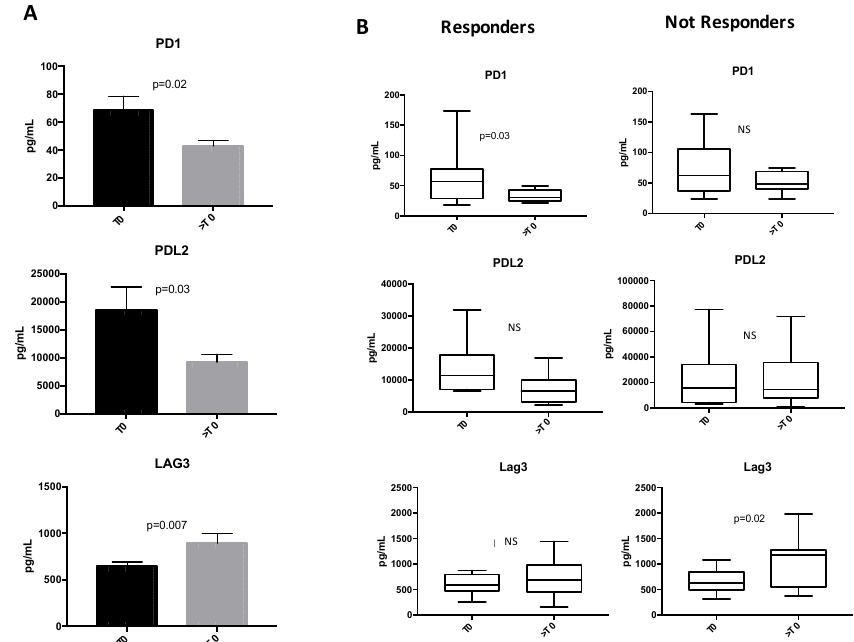
Figure 1. Changes of soluble immune checkpoints (sICs) in non-small cell lung cancer (NSCLC) patients during Nivolumab treatment. ( A ) Analysis of soluble immune check point-related proteins levels evaluated in the entire population of NSCLC patients before the beginning of Nivolumab treatment (T0) and at first clinical evaluation ( > T0). The proteins were analyzed by Luminex multiplex assay, and the results are reported as concentration (pg / mL) of sICs present in the patients’ sera. Histograms represent the concentration mean values ± SEM of soluble PD1 (T0 67 ± 10 pg / mL vs. > T0 41 ± 4 pg / mL), PDL2 (T0 18.6 ± 4 ng / mL vs. > T0 8 ± 1.4 ng / mL) and LAG3 (T0 627 ± 50 pg / mL vs. > T0 859 ± 109 pg / mL) at baseline (T0, black histograms) and at first clinical evaluation ( > T0, gray histograms). ( B ) Box plots of PD1, PDL2 and LAG3 in responding (R) and non-responding (NR) patients between nivolumab initiation (T0) and the first clinical evaluation ( > T0). The lines in the box show the median values. The error bars represent the minimum and the maximum values of sICs concentration (pg / mL). A Student’s paired t -test was used to compare the di ff erences between T0 and > T0. p values ≤ 0.05 were considered significant. NS = not significant.